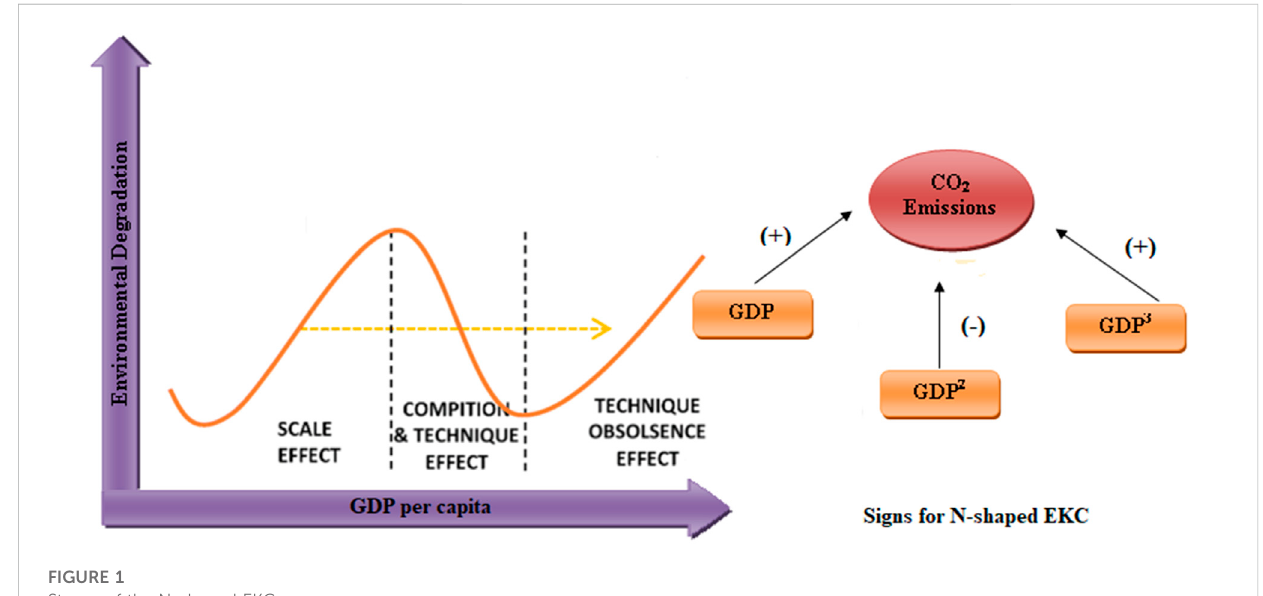
FIGURE 1 Stages of the N-shaped